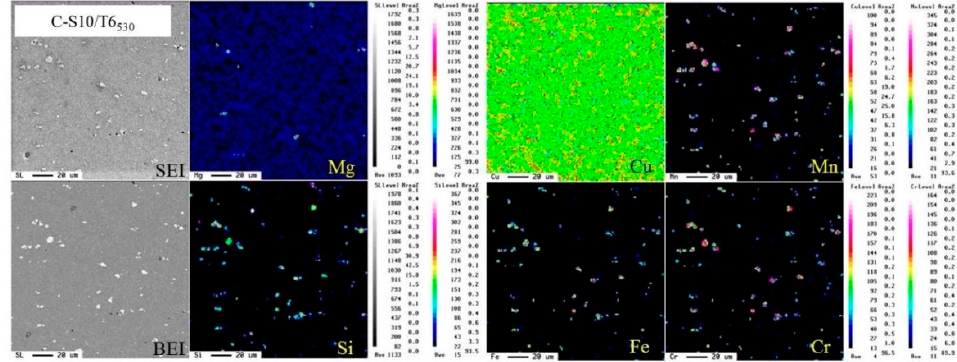
Figure 13. Elemental distribution of compressed TS ‐ SIMA alloy after T6 heat treatment (C ‐ S10/T6 530 ) obtained using EPMA.